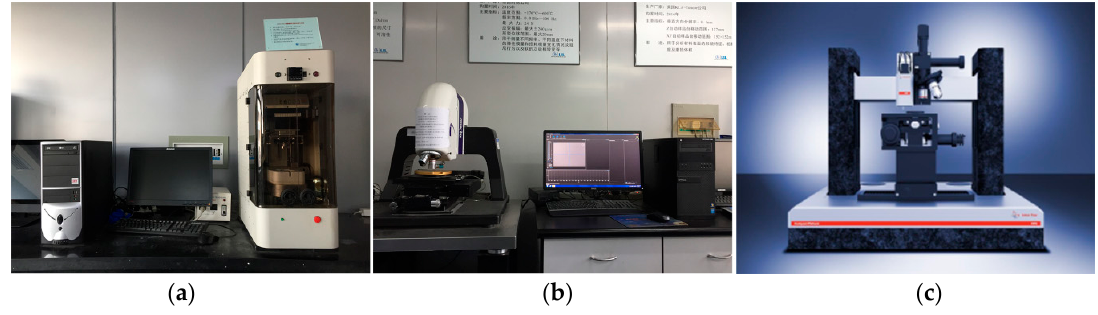
Figure 4. Elemental distribution maps for the surface of EP + 6%MoS 2 + 6%H-CNTs.